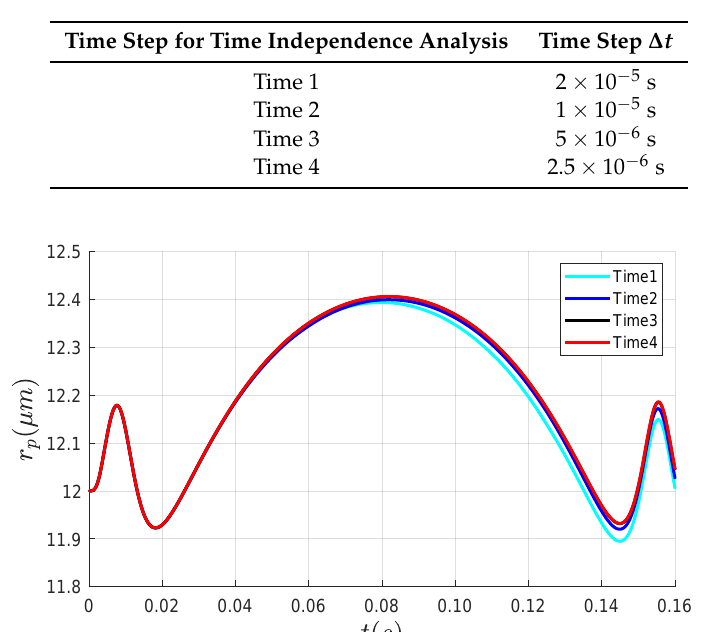
Table A1. Four time independence analysis for 18,571 computational domain elements and 152 particle surface elements.